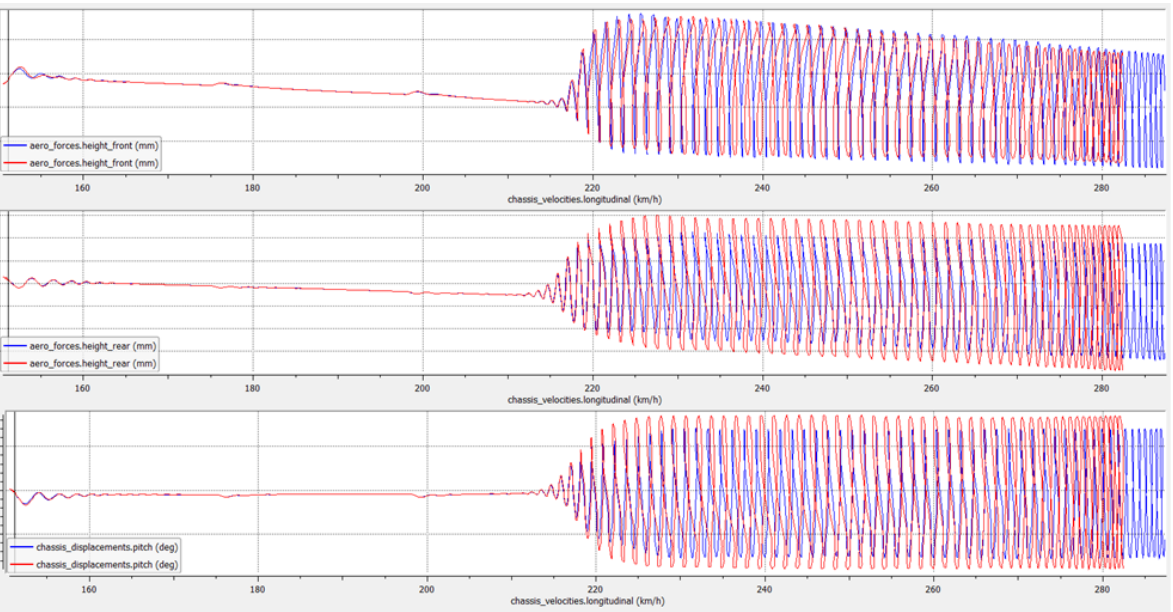
Figure 19. Increased front damping (blue plot) results in a slightly reduced amplitude at the rear end ( center plot), showing that front and rear axles are strongly coupled through body pitch oscillations ( bottom plot). In addition, the modified car can reach a higher speed in the same simulation time: this is due to increased aerodynamic efficiency in terms of drag reduction.